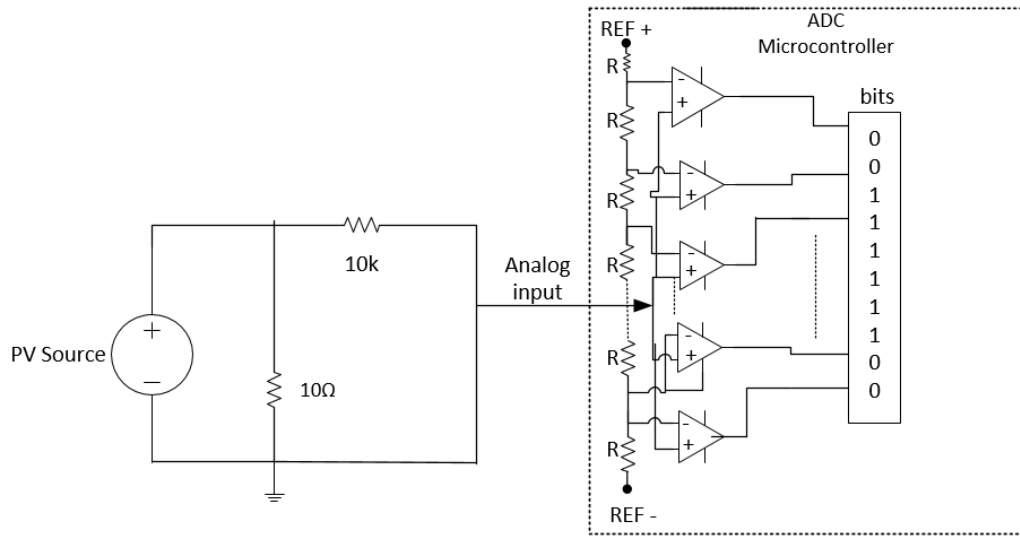
Figure 7. Circuit diagram for irradiance measurement.